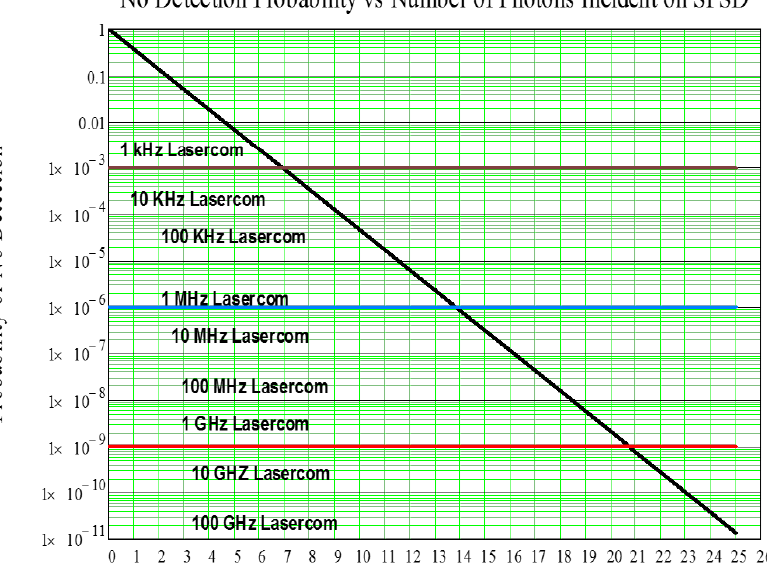
Figure 3. A plot of the number of received photons per bit vs. the probability that a “one” will not be properly detected in a wideband OOK communications system equipped with single-photon sensitive detectors. For example, with 14 photons received per bit, only 1 in a million (MHz) “ones” would be missed, while with 21 photons received per bit, only 1 in a billion (GHz) “ones” would be missed. To account for internal instrument or background light noise, one can set a photon threshold below which a “zero” bit is highly likely.